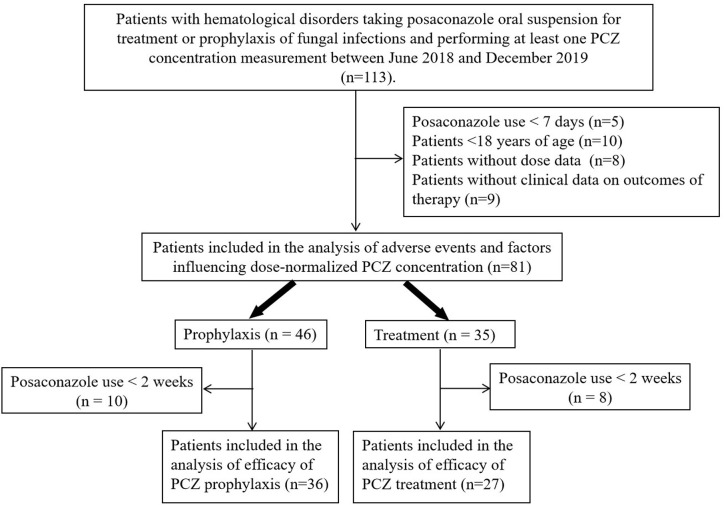
Flow chart of the study.